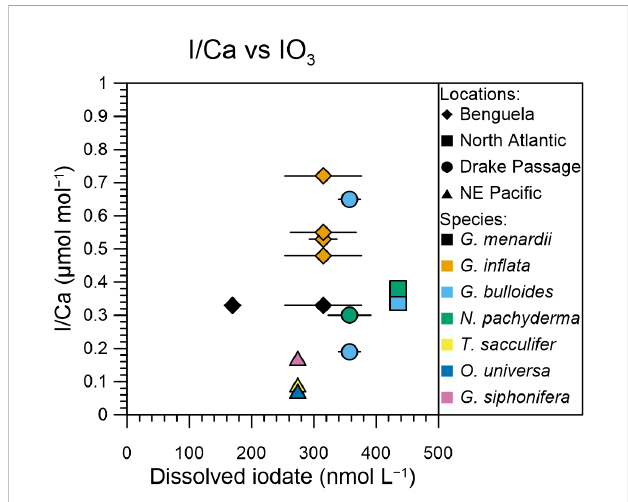
FIGURE 4 I/Ca of planktic foraminifera relative to dissolved mean iodate from the upper 120 m of the water column, representing the habitat of the analyzed species. Iodate values are from representative pro fi les up to 400 km away from the foraminifer sampling site as detailed in section